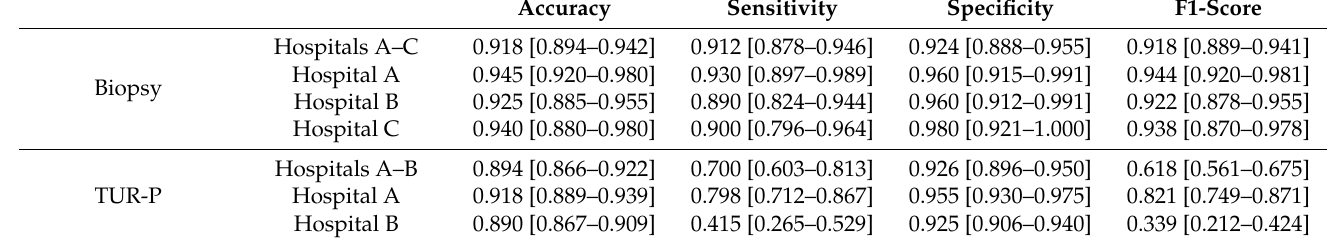
Table 5. Accuracy, sensitivity, specificity, and F1-score results of the transfer learning model (TL-colon poorly ADC-2 (20 × , 512)) from the existing colon poorly differentiated adenocarcinoma model for prostate adenocarcinoma on the biopsy, TUR-P, and TCGA test sets.